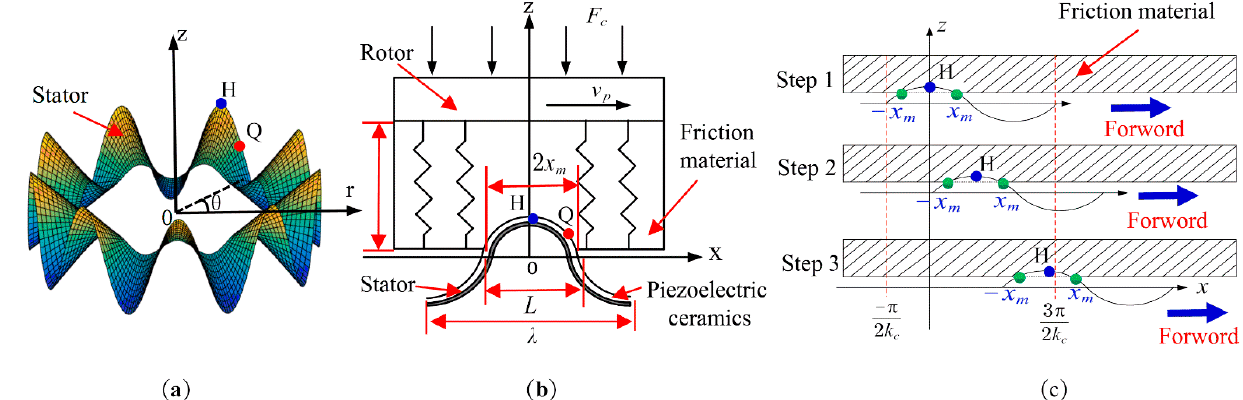
Figure 2. A schematic diagram of the stator vibration mode and contact state: ( a ) schematic diagram of the stator vibration mode; ( b ) a schematic diagram of the stator and rotor contact state; and ( c ) a motion diagram of the particle point at the stator drive end.